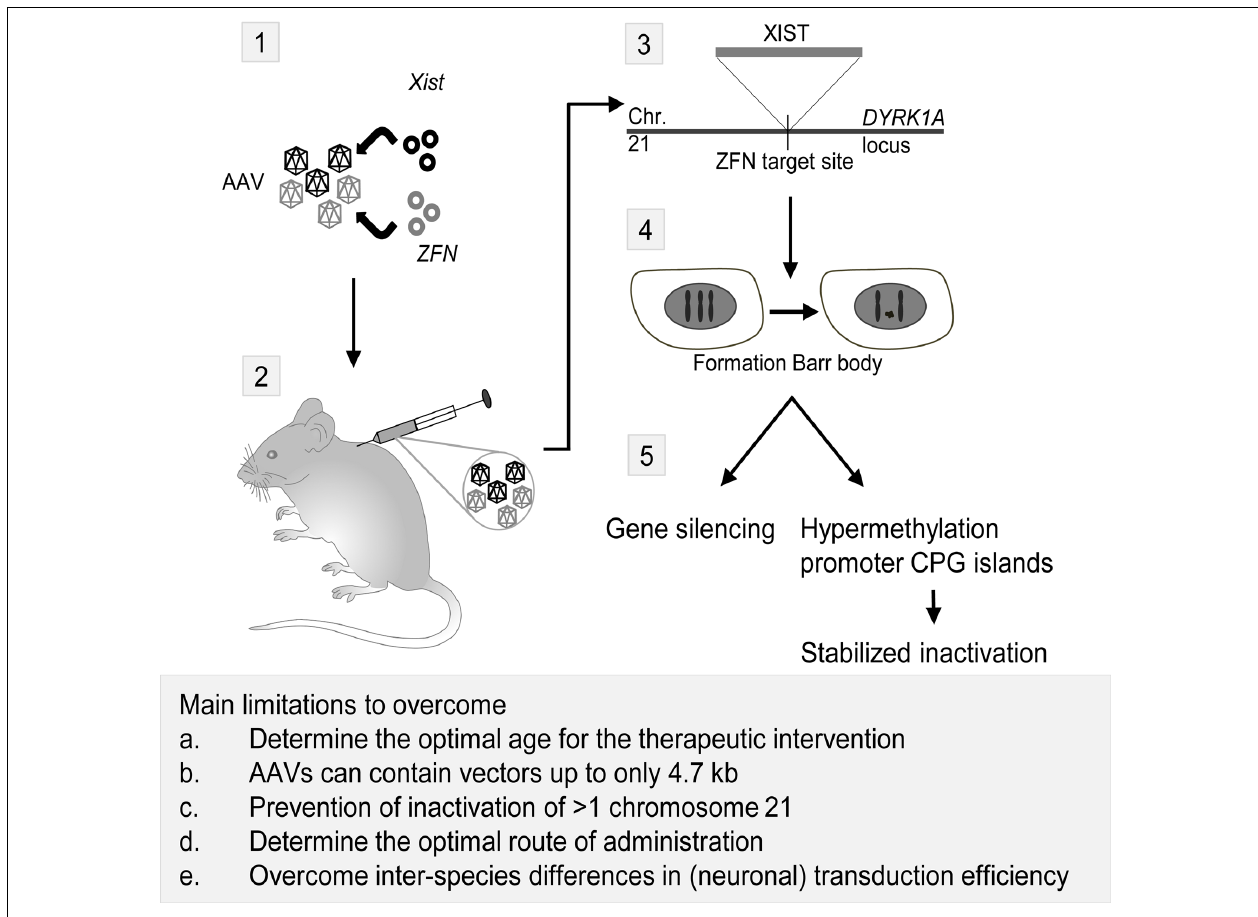
FIGURE 2 | Proposed strategy for a therapeutic application of Xist and zinc finger nucleases (ZFN) to treat trisomy 21. Adeno-associated viruses (AAVs) are currently the most promising CNS gene delivery vector (for review, see Gray, 2013). As shown in this scheme, the first step in the approach would be incorporation of plasmids containing Xist and ZFN targeted to the DYRK1A locus on chromosome 21 in AAVs (1). Next, injection of the viruses in rodents can be performed intracranial, intravenous or in the cerebrospinal fluid (2). Intracranial injections have been successfully performed in mammals as large as cats, but an estimated number of 20–30 required injections per hemisphere in human infants rendered this technique unfavorable over alternatives (Vite etal., 2005). AAV9 vectors have the capacity to cross the blood-brain barrier and transduce neurons and astrocytes (Foust etal., 2009), making intravascular injection of viral vectors for CNS targeted gene therapy a possibility.The third possible route of administration is injecting the viral vectors in the cerebrospinal fluid (CSF), thus transducing the central nervous system effectively even in non-human primates (Samaranch etal., 2012). After injection of the AAVs and transduction of the viruses in the cells, Xist will be incorporated on the ZFN target site in the DYRK1A locus on chromosome 21 (3). Here, it will induce the formation of a chromosome 21 Barr body